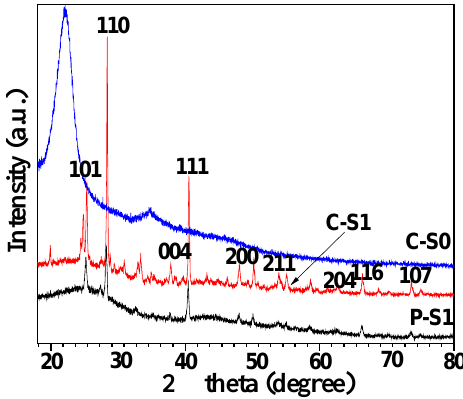
Figure 6. XRD patterns of C-S0, C-S1, and P-S1.